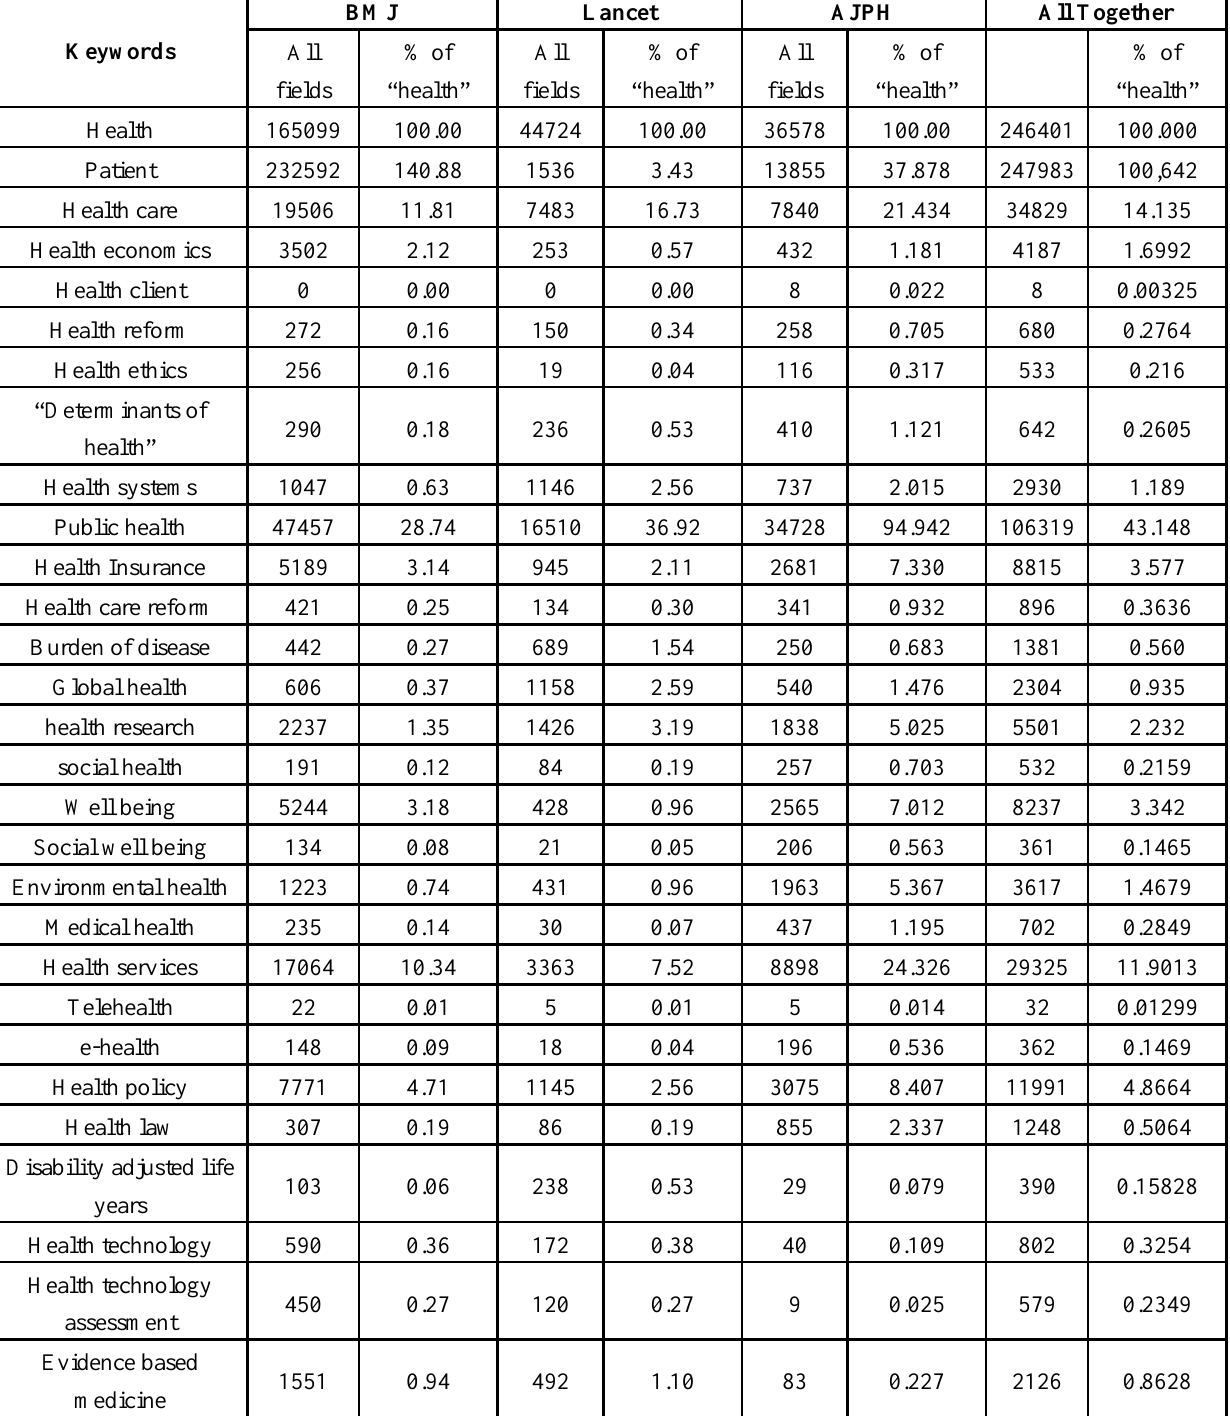
Table 2. Frequency of health policy terms covering different areas in British Medical Journal (BMJ), AJPH and